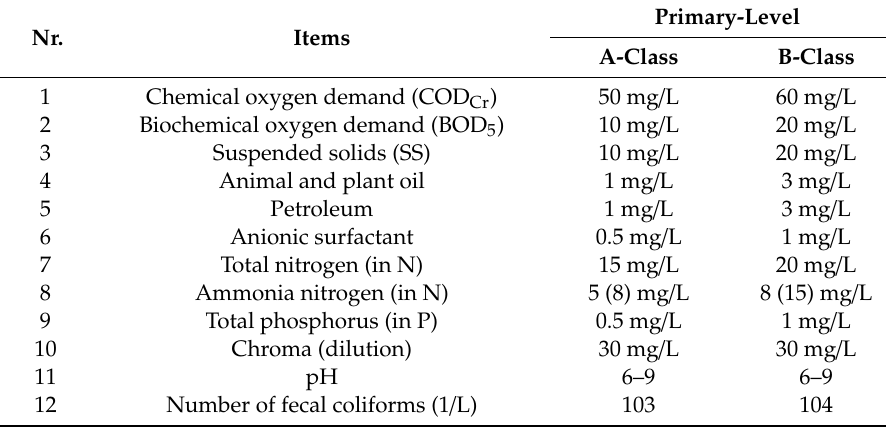
Table 1. Pollutant discharge standards of urban sewage treatment plants. Nr.